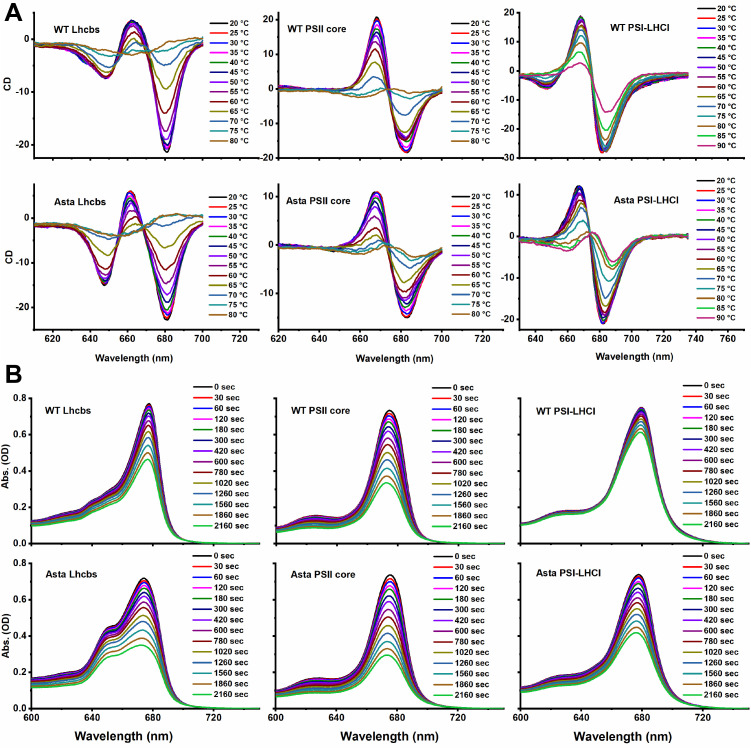
Original CD (A) and absorption (B) spectra.(A) Denaturation and (B) photobleaching.